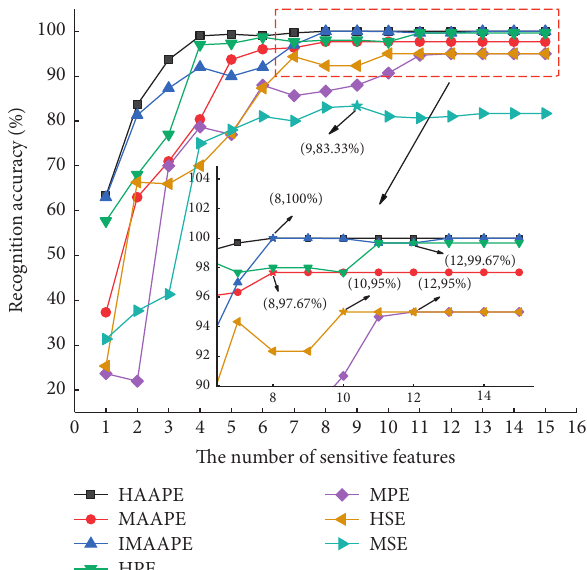
Figure 10: The relationship between the number of features and the recognition accuracy.